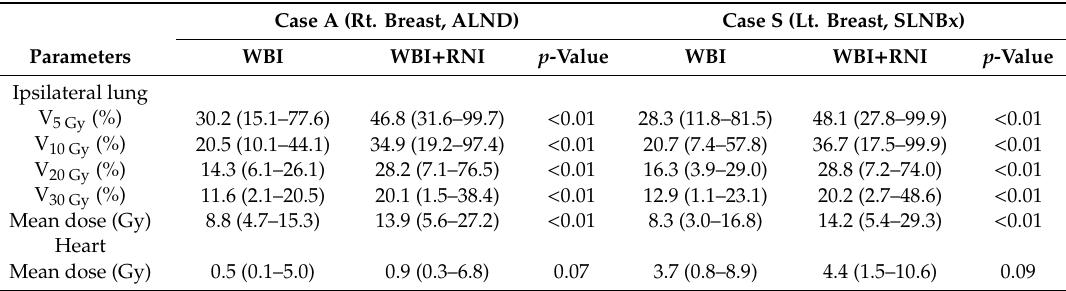
Table 3. Dosimetric parameters for lung and